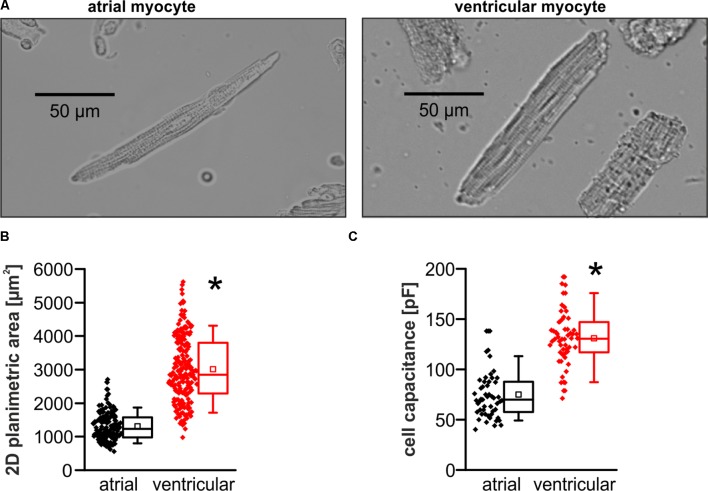
Basic differences in morphometry between atrial and ventricular myocytes. (A) Exemplary microscopic images demonstrate morphological differences between murine atrial and ventricular myocytes. Atrial myocytes exhibit a smaller 2D cell area compared to ventricular myocytes (B) and consistently a reduced electrical cell capacitance (C). ∗p < 0.05 atrial vs. ventricular.